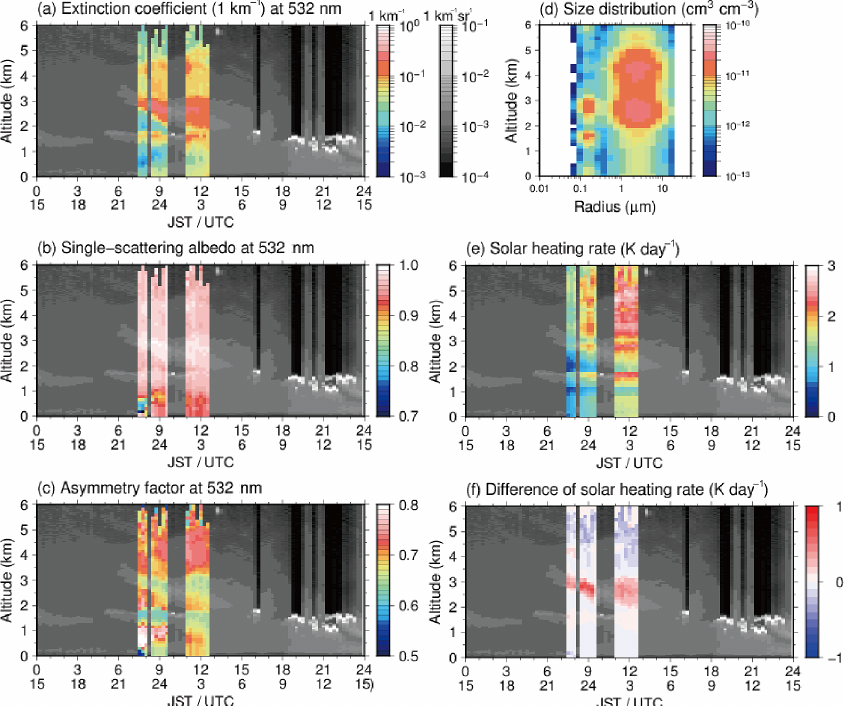
Figure 17. Retrieval results for the transported dust on 2 April 2012 in Tsukuba, Japan: (a) extinction coefficient at 532nm, (b) single- scattering albedo at 532nm, (c) asymmetry factor at 532nm, (d) size distribution, (e) solar heating rate, and (f) solar heating rate difference from that calculated using the vertical mean of the asymmetry factor. The gray shading shows the attenuated backscatter coefficient at 532nm by